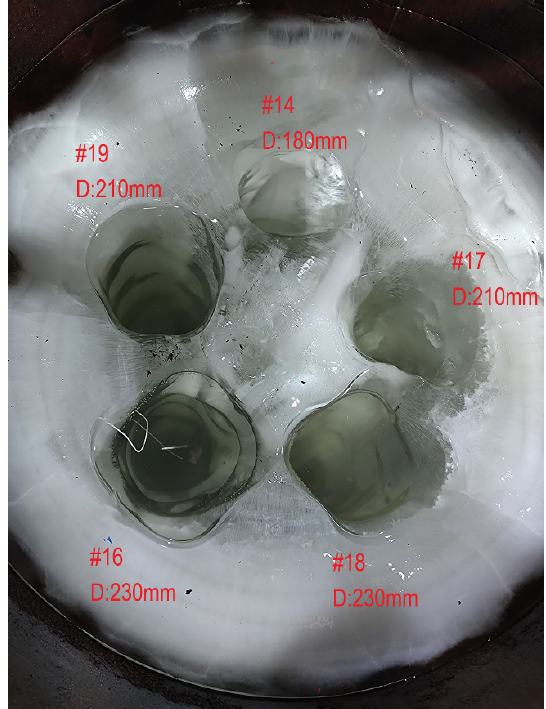
Figure 10. Borehole shape obtained by drilling with different nozzles.